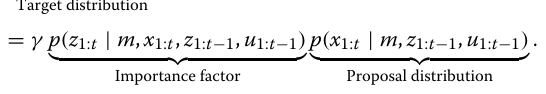
We formulate our GPS and LIDAR fusion on both FS 1.0 and FS 2.0 because both FS 1.0 and FS 2.0 are renowned RBPFs.